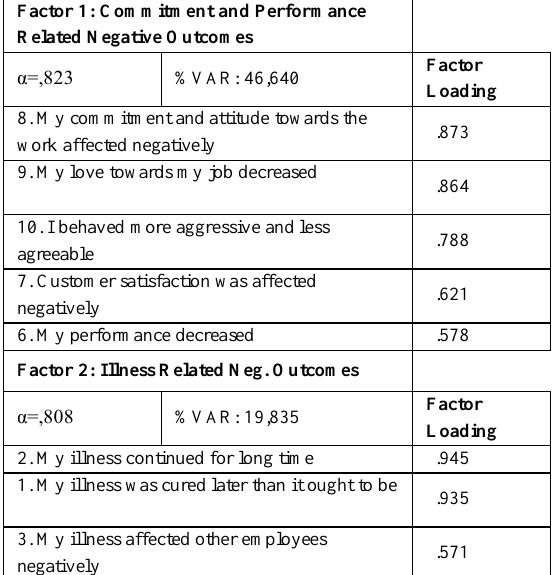
Table 12: Results of Exploratory Factor Analysis for Negative Outcomes of Presenteeism